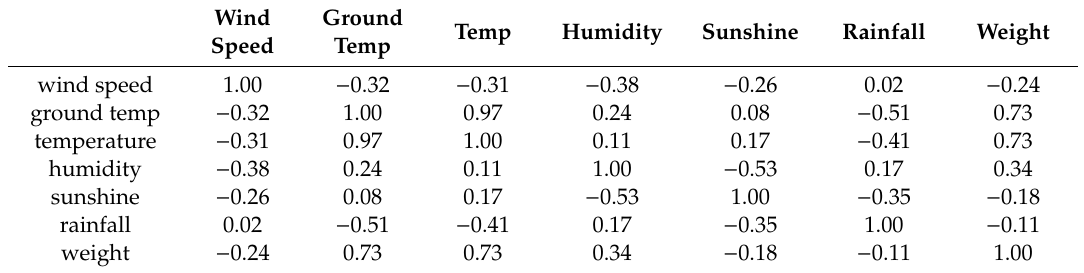
Table 4. Correlation coe ffi cients between onion weight and six environmental factors.